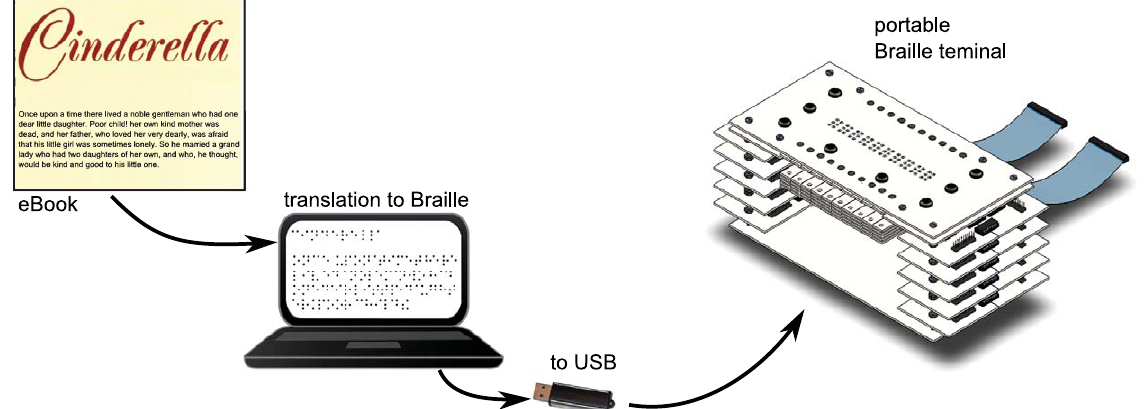
Fig. 1. The TactoBook concept: eBooks in portable Braille terminals.